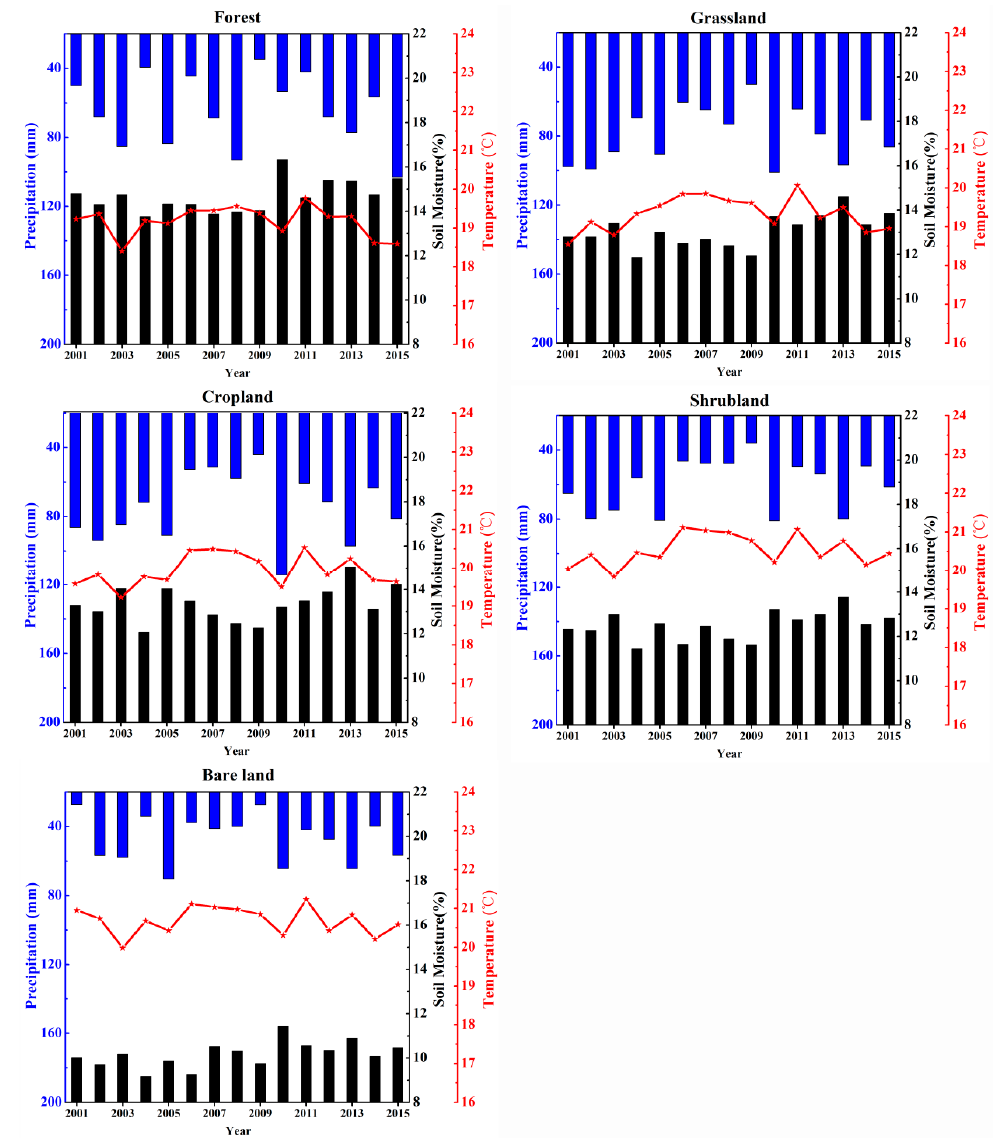
Figure 8. Interannual variations of soil moisture, precipitation, and temperature in different land cover types from 2001 to